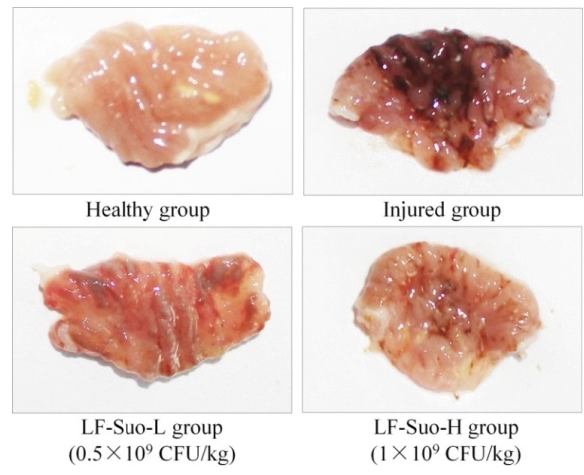
Figure 1. Stomachs of studied mice. Table 2. Stomach appearance of studied mice.